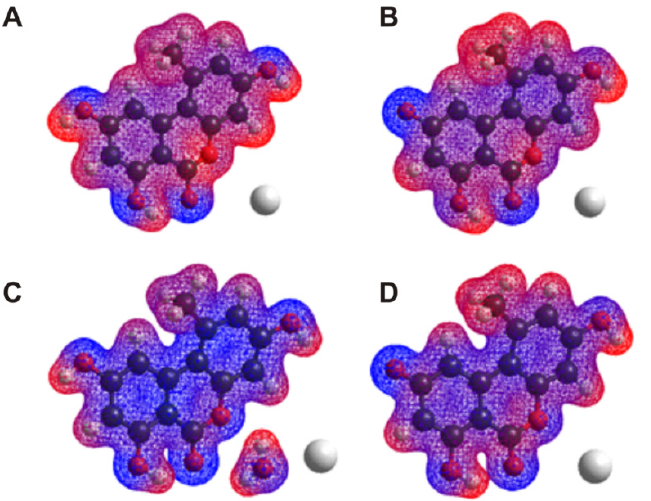
Figure 7. Electrostatic potential map associated to the most stable equilibrium conformations of AOH-cation complexes: nonionic AOH-Mg 2+ ( A ), monoanionic AOH-Mg 2+ ( B ), nonionic AOH-Ca 2+ ( C ), and monoanionic AOH-Ca 2+ ( D ).